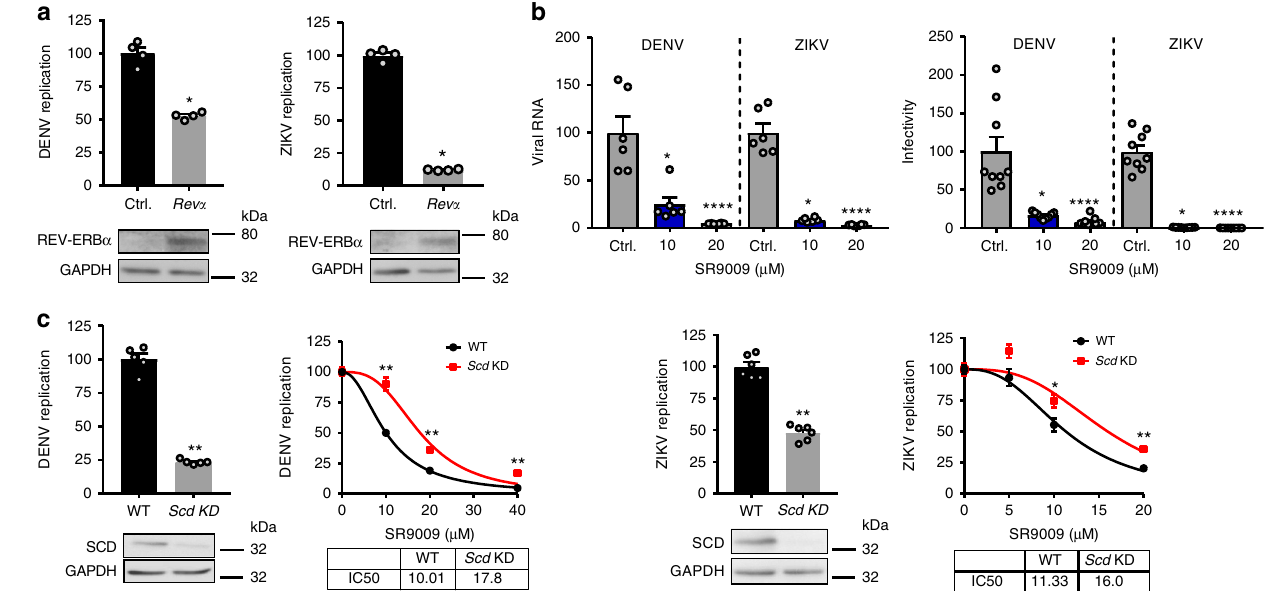
Fig. 6 REV-ERB inhibits DENV and ZIKV replication. a Overexpressing REV-ERB α inhibits DENV and ZIKV replication. Huh-7 cells harbouring sub-genomic DENV RNA or ZIKV-Nanoluc were transfected with REV-ERB α expression plasmid or Ctrl empty vector (2 µ g). DENV or ZIKV replication was assessed by measuring luciferase activity 48 h later and data expressed relative to untreated Ctrl cells (mean ± S.E.M., n = 4, Mann – Whitney statistical test). REV-ERB expression was con fi rmed by western blotting. b REV-ERB agonist SR9009 inhibits DENV and ZIKV infection. Huh-7 cells were infected with DENV2 16681 at a MOI of 0.1 and treated with SR9009 for 48 h ( n = 3). Extracellular viral RNA and the infectious titre of secreted virus was quanti fi ed and the data expressed relative to untreated Ctrl cells, where the mean titre of virus secreted from untreated cells was 1.6 × 10 5 pfu/ml. Huh-7 cells were infected with ZIKV MP1751 at an MOI of 0.1 and treated with SR9009 for 48 h. Extracellular RNA and infectious titre was quanti fi ed and the data expressed relative to untreated cells, where the mean titre of virus secreted from untreated cells was 2.9 × 10 6 pfu/ml. c A role for SCD in REV-ERB agonist inhibition of DENV and ZIKV replication. DENV replicon cells or ZIKV-Nanoluc infected cells were transfected with CRISPRs targeting exons 2 and 3 of SCD or a scrambled guide RNA and 24 h later treated with SR9009. SCD expression was measured by western blotting and the dose of REV-ERB agonist required to inhibit DENV or ZIKV replication by 50% (IC 50 ) in WT or KD cells determined (mean ± S.E.M., n = 6, Mann – Whitney statistical